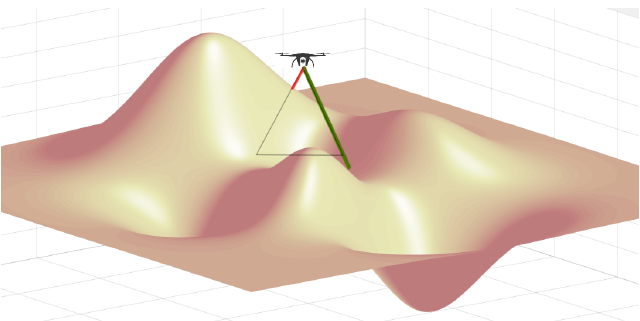
Figure 3. The coverage of the drone is impacted by topography’s